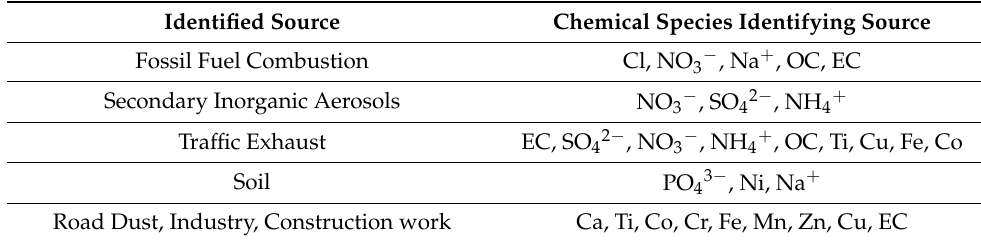
Table 3. Sources of PM 10 identified by